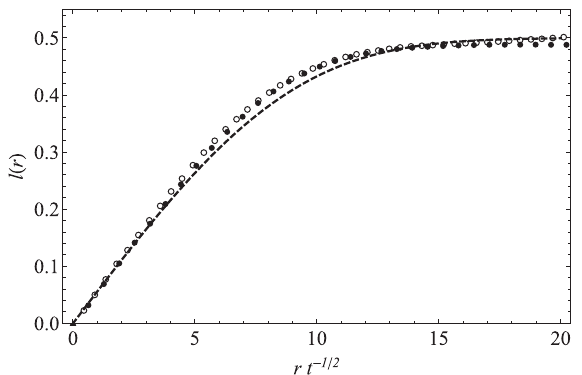
FIG. 13. Séguy ’ s curve showing linguistic distance ( l ) versus geographical distance ( r ). Dashed line shows Eq. (19) in the case σ ¼ 4 , β ¼ 2 . Open and closed dots show simulated linguistic distances using same parameter values in a 1000 × 1000 system at times t ¼ 80 , 160. Note that linguistic distance depends only on the combination rt − 1 = 2 , so curves evaluated at different times collapse onto one another.